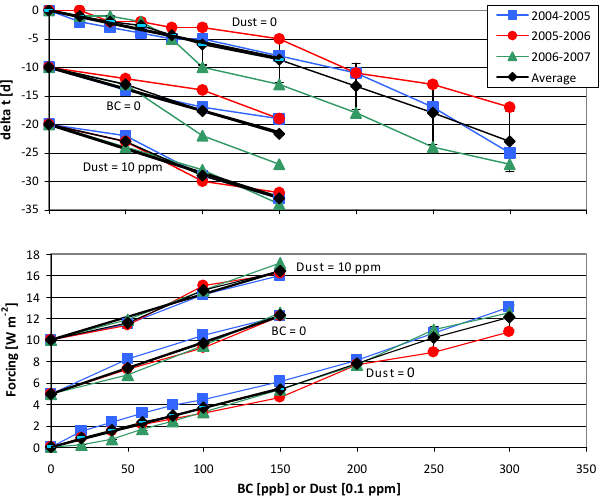
Figure 7. Top: reduction in the snow-covered period in days, sim- ulated for different BC and dust concentrations in the snow. Bot- tom: simulated annual radiative forcing related to shortwave ra- diation due to the presence of BC and dust in the snow. Simula- tions are performed without dust, without BC (shifted by − 10 days or + 5Wm − 2 ) , and with dust = 10ppm (shifted by − 20 days or + 10Wm − 2 ) . In the last case, the reductions are calculated relative to the case with BC = 0 and dust = 10ppm. Black symbols indicate the 3-year averages of the radiative forcing with the error bars rep- resenting the standard deviation. Black lines correspond to linear regressions forced through the origin for the average values for BC ≤